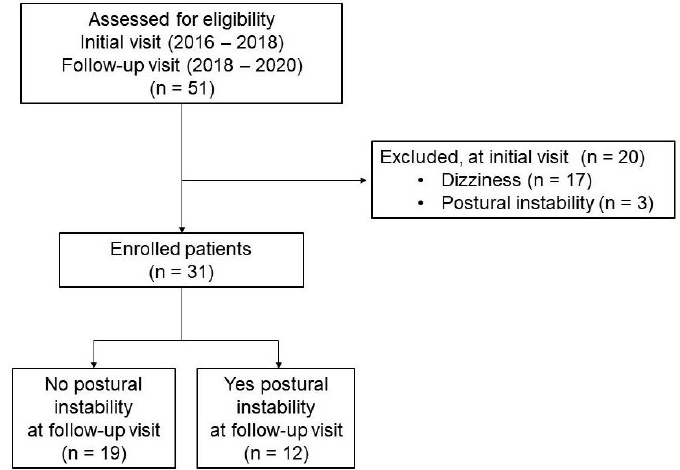
Figure 1. Patient